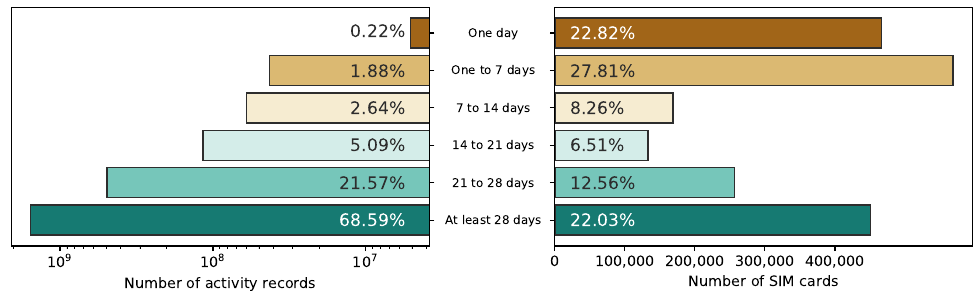
Figure 2. SIM card distribution of the “June 2016” data set, by the number of active days. Type allocation codes are provided for every record because a subscriber can change their device at any time. Naturally, most of the subscribers (95.71%) used only one device during the whole observation